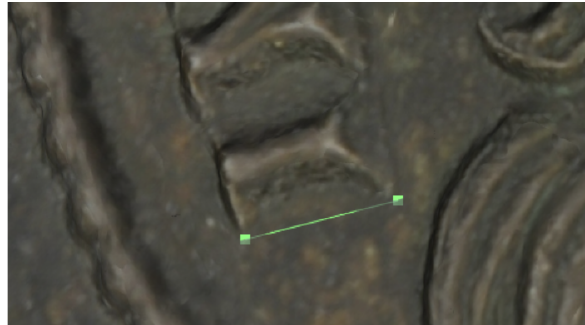
Figure 5. The green line near the first letter on the left of the inscription indicates a linear measurement. In this case, on the left of the image, the result appears within a pop-up near the on-screen button of the